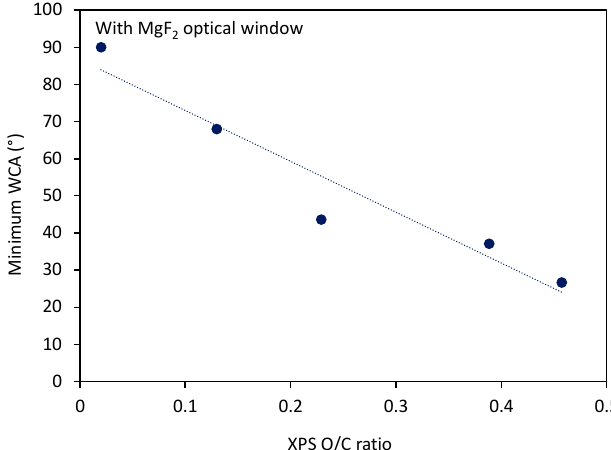
Figure 4. Correlation between the minimum water contact angle and O / C ratio for the case when samples were covered with the optical window.